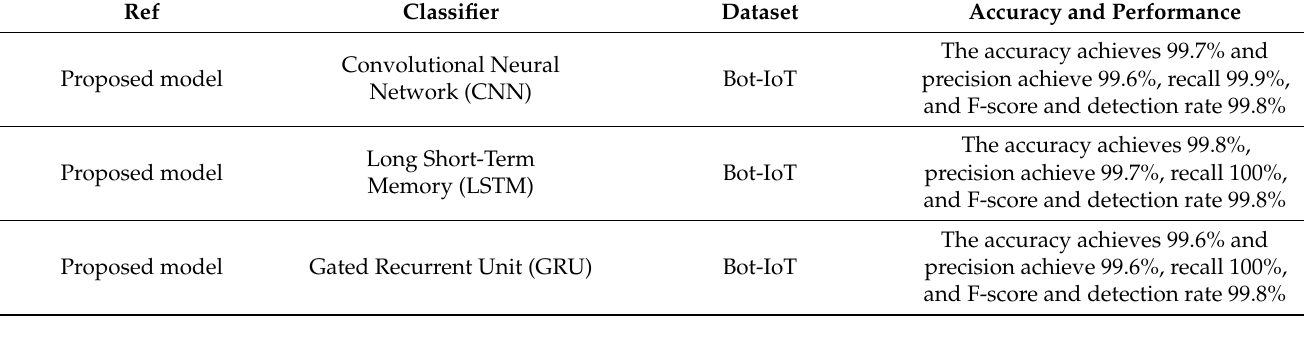
Figure 2. Experiment results for accuracy and false alarm.